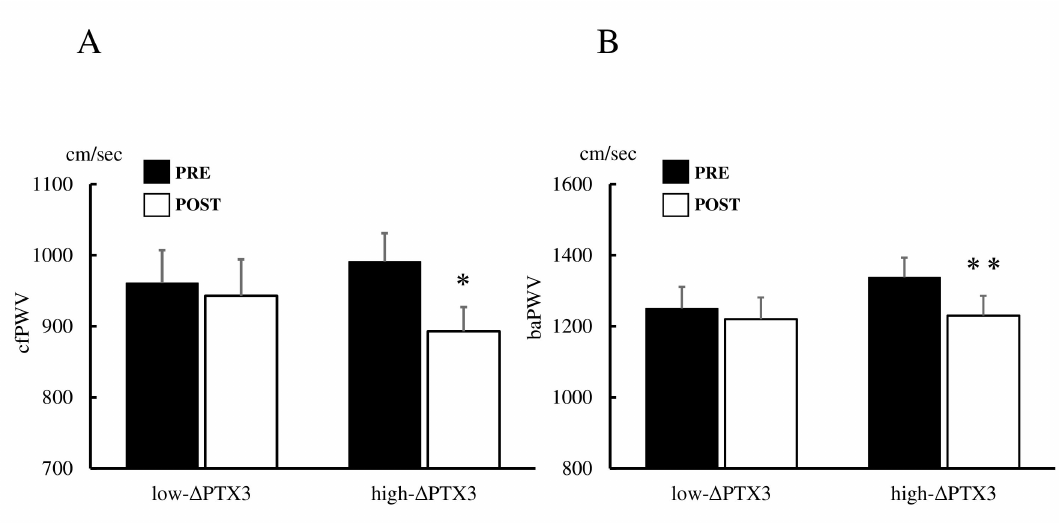
Fig. 2. Changes in (A) baPWV and (B) cfPWV before and after dietary modification program in the high and low ∆ PTX3 groups. ** p < 0.01, * p < 0.05 vs.